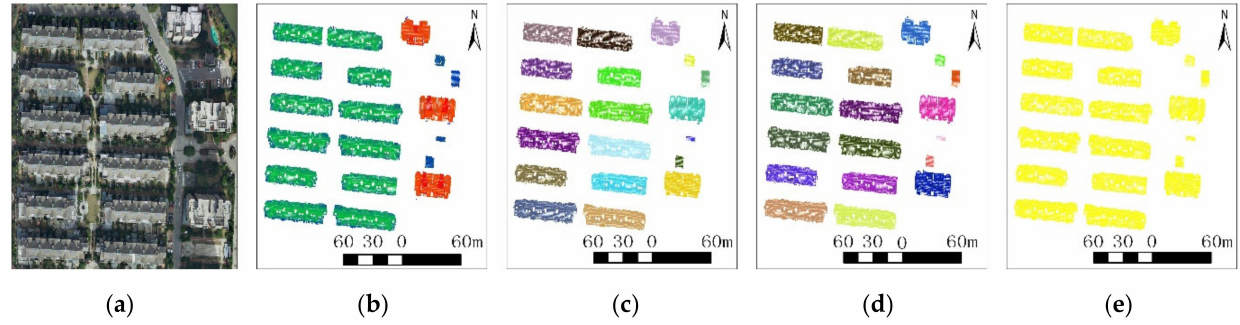
Figure 8. Building instance segmentation result of dataset 1: ( a ) Aerial image corresponding to input data; ( b ) the building point clouds; ( c ) the result of UBIS method; ( d ) the ground truth; ( e ) the main differences between the UBIS method result and the ground truth.